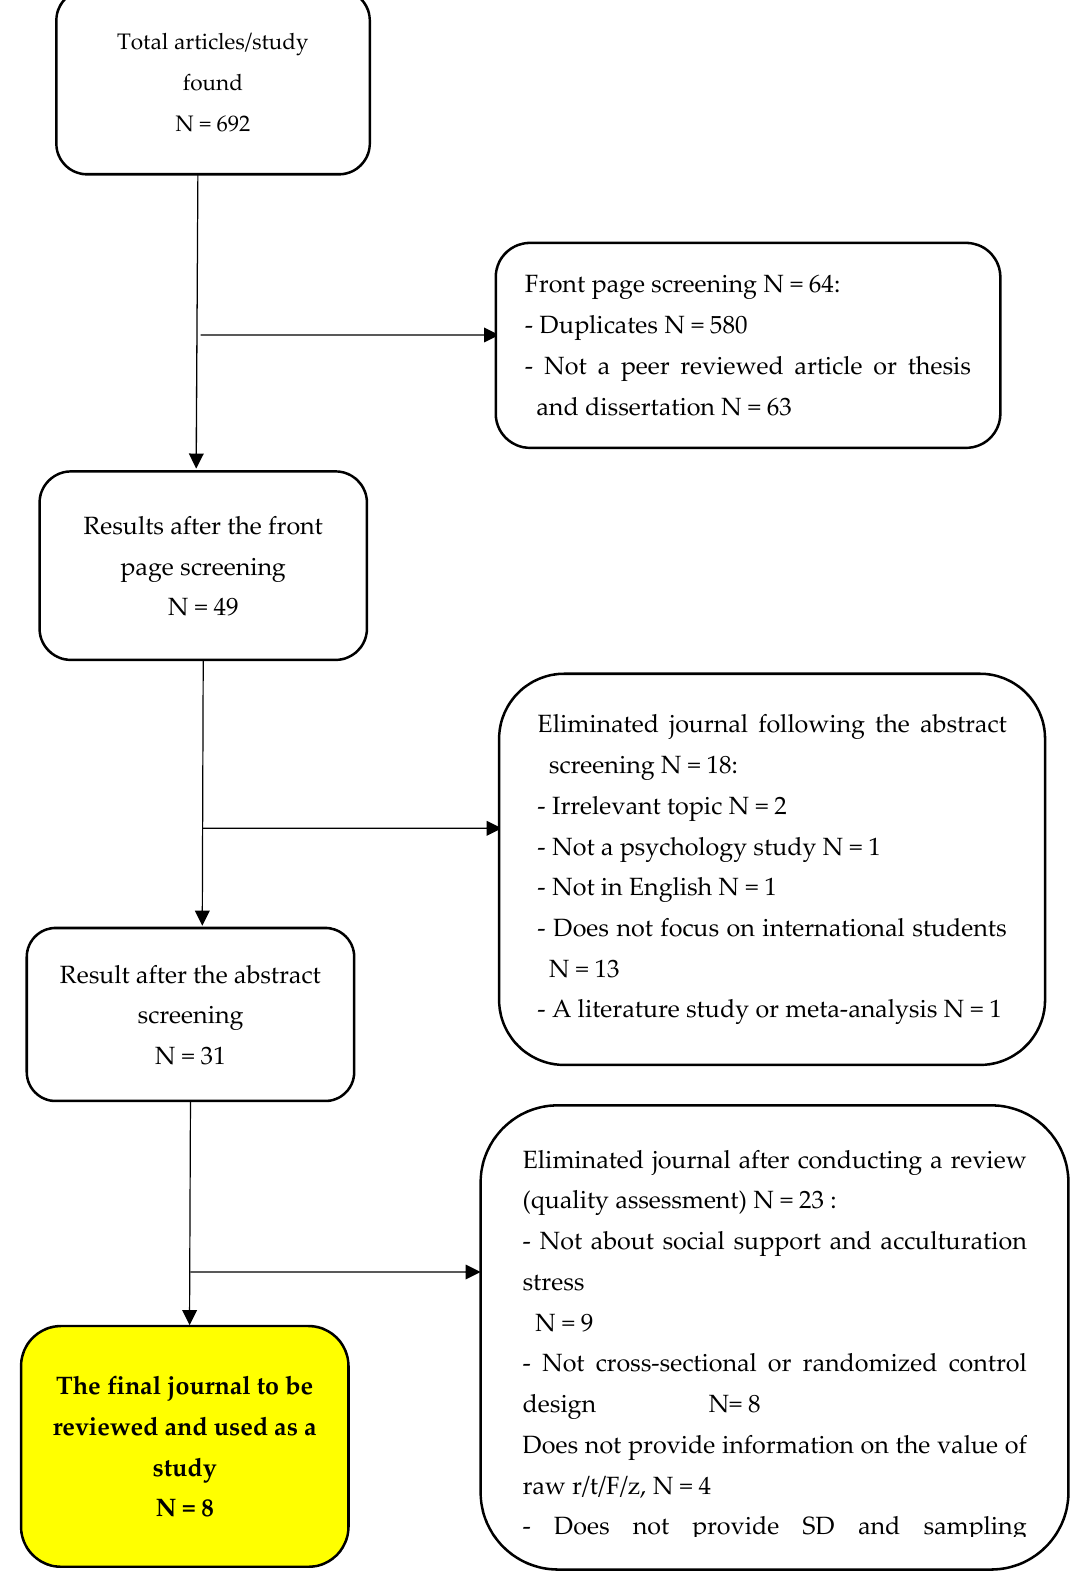
Figure 1. PRISMA flowchart study selection.